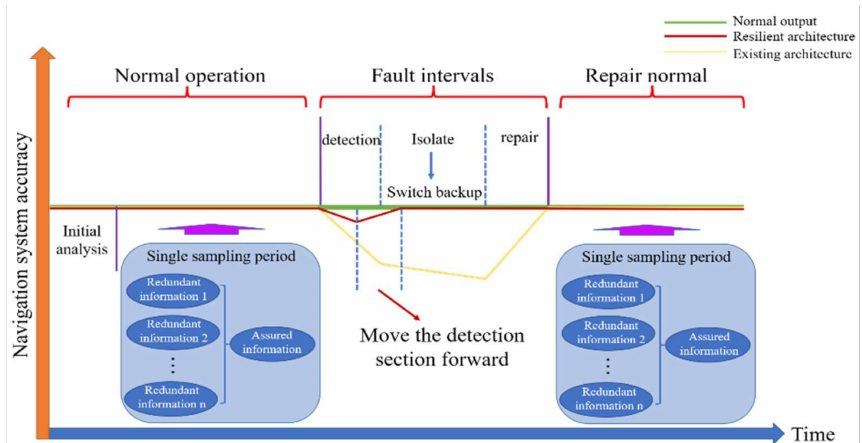
Figure 1. Resilient fusion architecture.